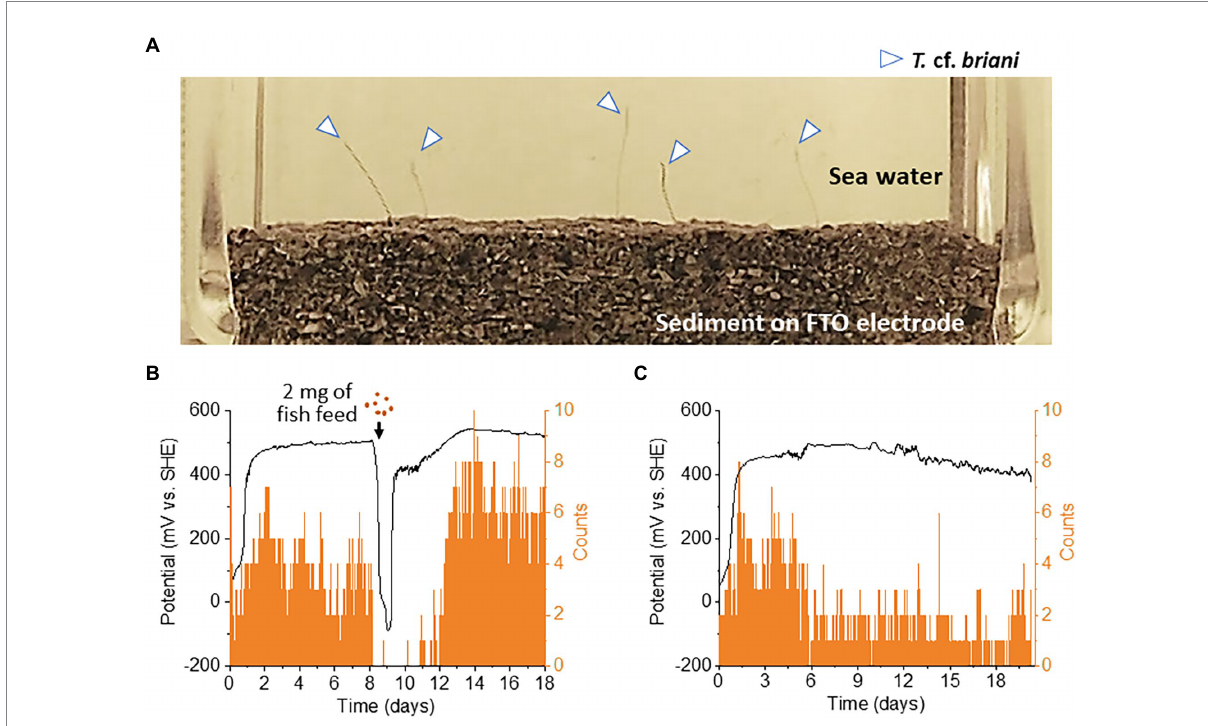
FIGURE 3 (A) Photograph of the seawater-sediment interface taken during open-circuit potential measurements. The arrows show the tail of an oligochaete protruding from the sediment layered on an fluorine-doped tin oxide (FTO)-coated glass electrode. (B,C) Correlation between redox potential and the number of tails protruding from the sediment into sea water. On day 8 of the experiment, 2 or 0 mg of fish feed ( B,C , respectively) was added to the